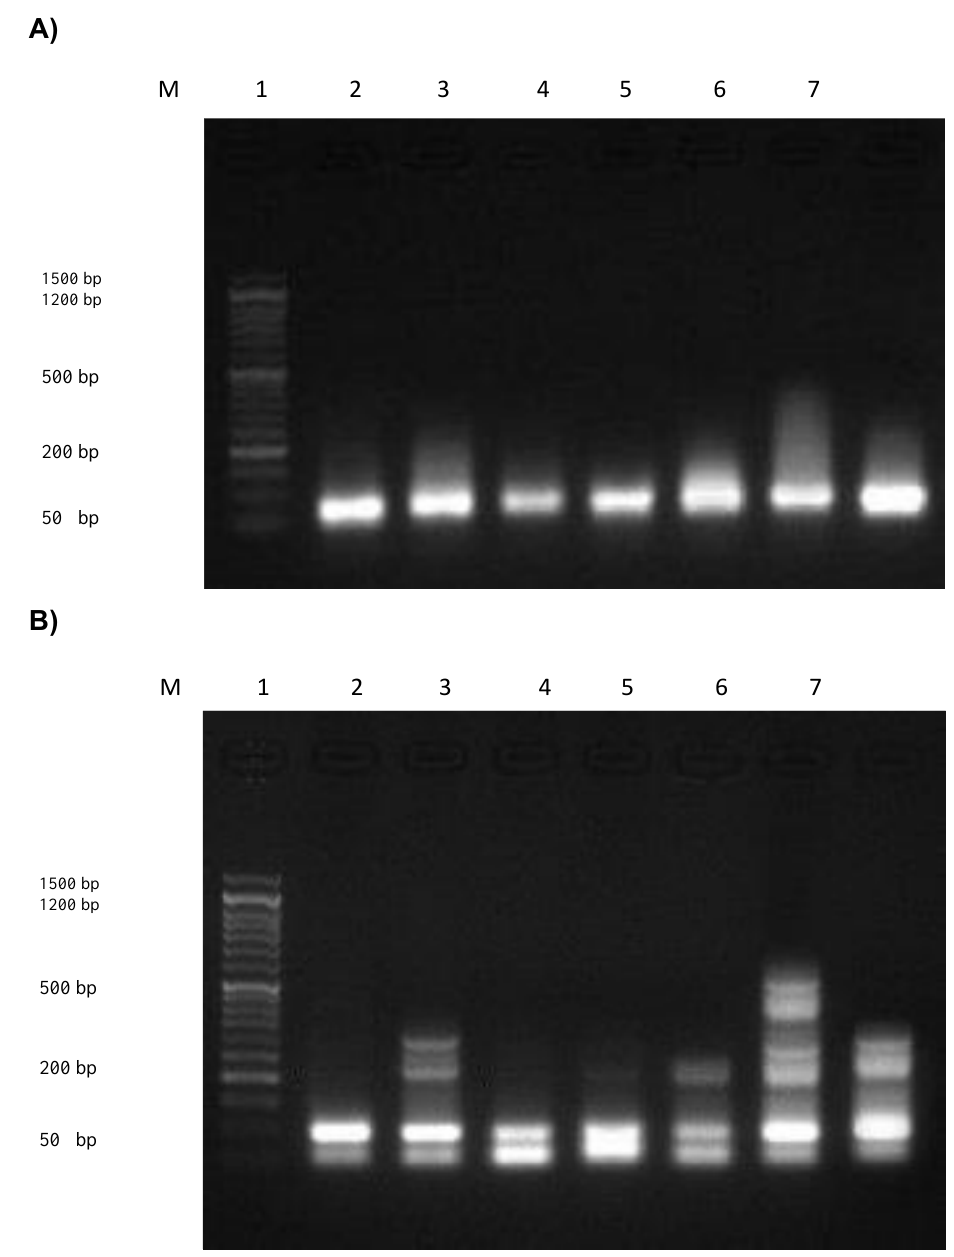
Figure 8. DNA fragmentation was detected with Agarose gel in normal skin cell lines ( A ) and skin cancer cell lines ( B ) treated with different CXB compounds. M: represent DNA marker, Lane 1: represents negative normal skin cell lines (-ve), Lanes 2-6: represent normal skin cell lines treated with TES suspension, blank HPMC hydrogel, CXB hydrogel, CXB-TES hydrogel, and CXB powder, respectively, Lane 7: represents positive skin cell lines treated with doxorubicin (+ve control).